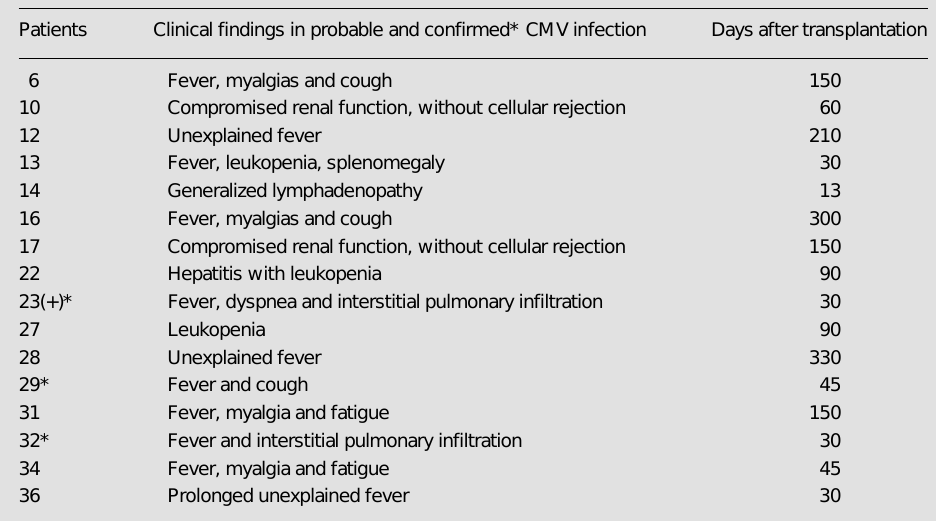
Table 2 - Clinical features of patients who developed CMV infection. (+) Fatal